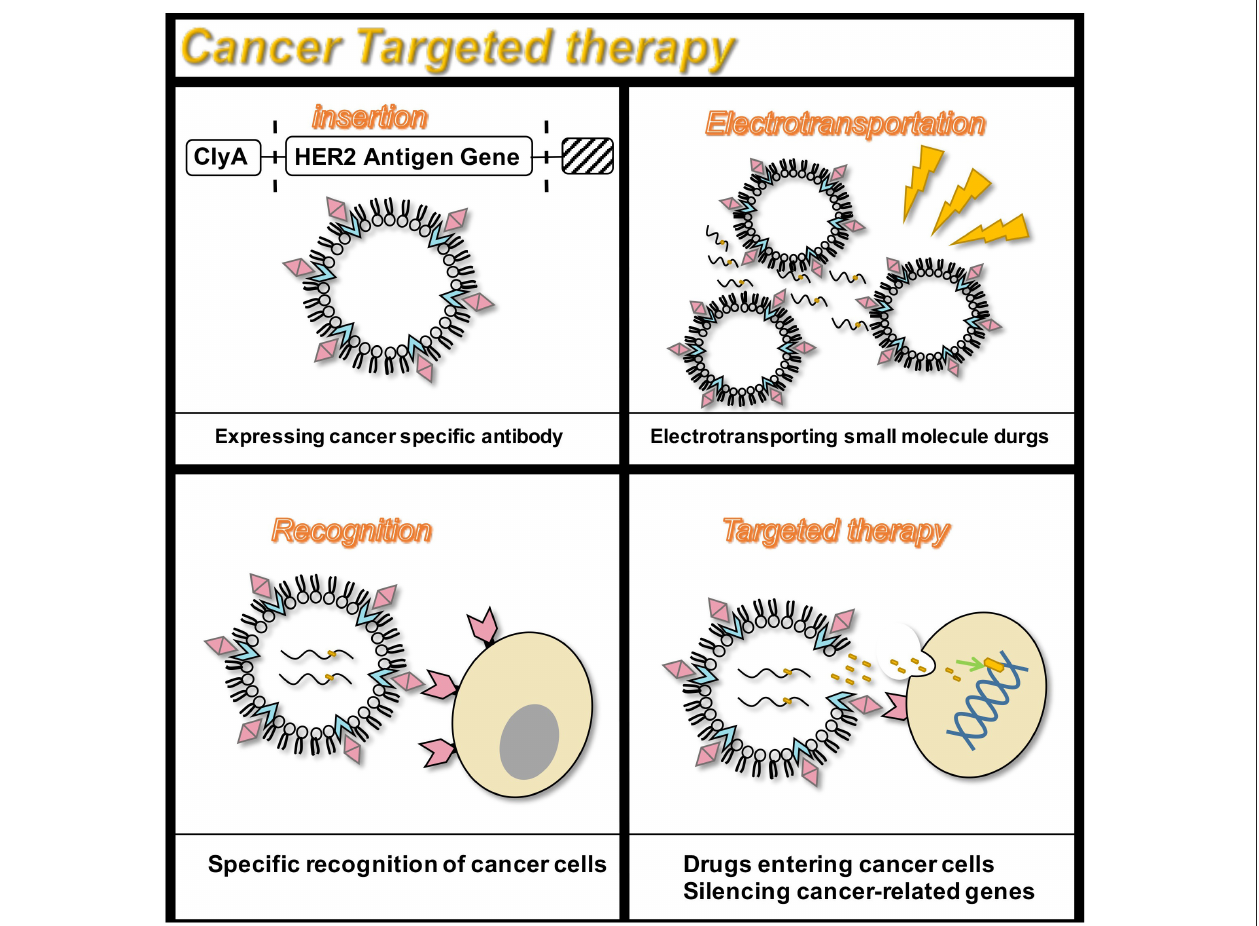
FIGURE 3 | Targeted therapy for the HER2 receptor. OMVs are genetically engineered to carry siRNA that silence cancer genes, and specifically target cancer cells that express the HER2 antigen to exert anti-cancer effects.